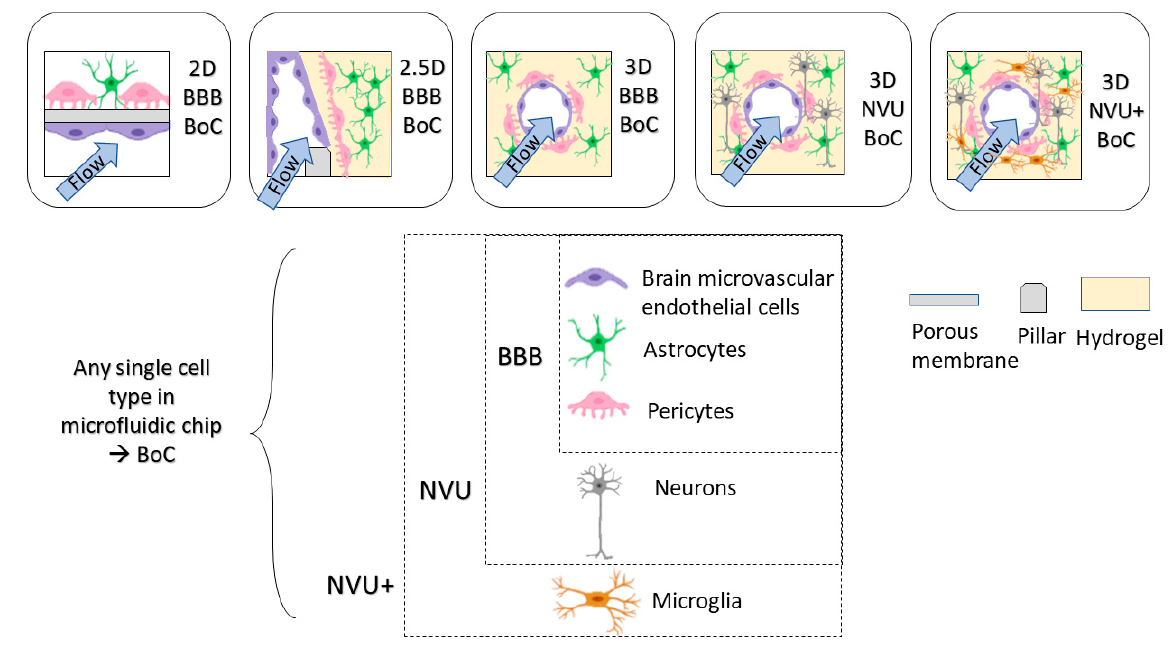
Figure 3. Dimensions of BoC devices. BoC devices can range from 2D, 2.5D, 3D with specific cell types to model BBB (EC, pericytes, astrocytes) or NVU (EC, pericytes, astrocytes, neurons).